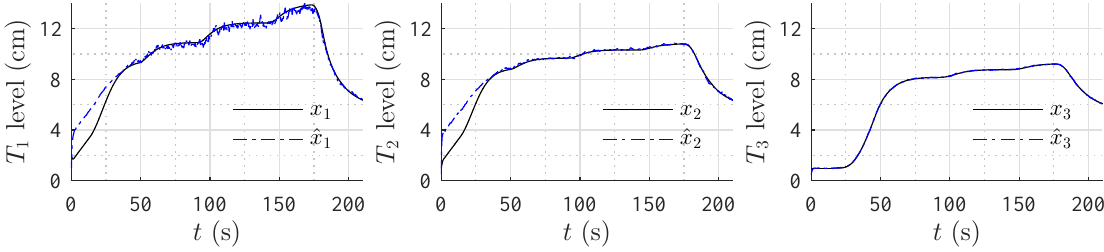
Figure 7. Simulation with v-notch weir at T 2 and circular weir at T 3